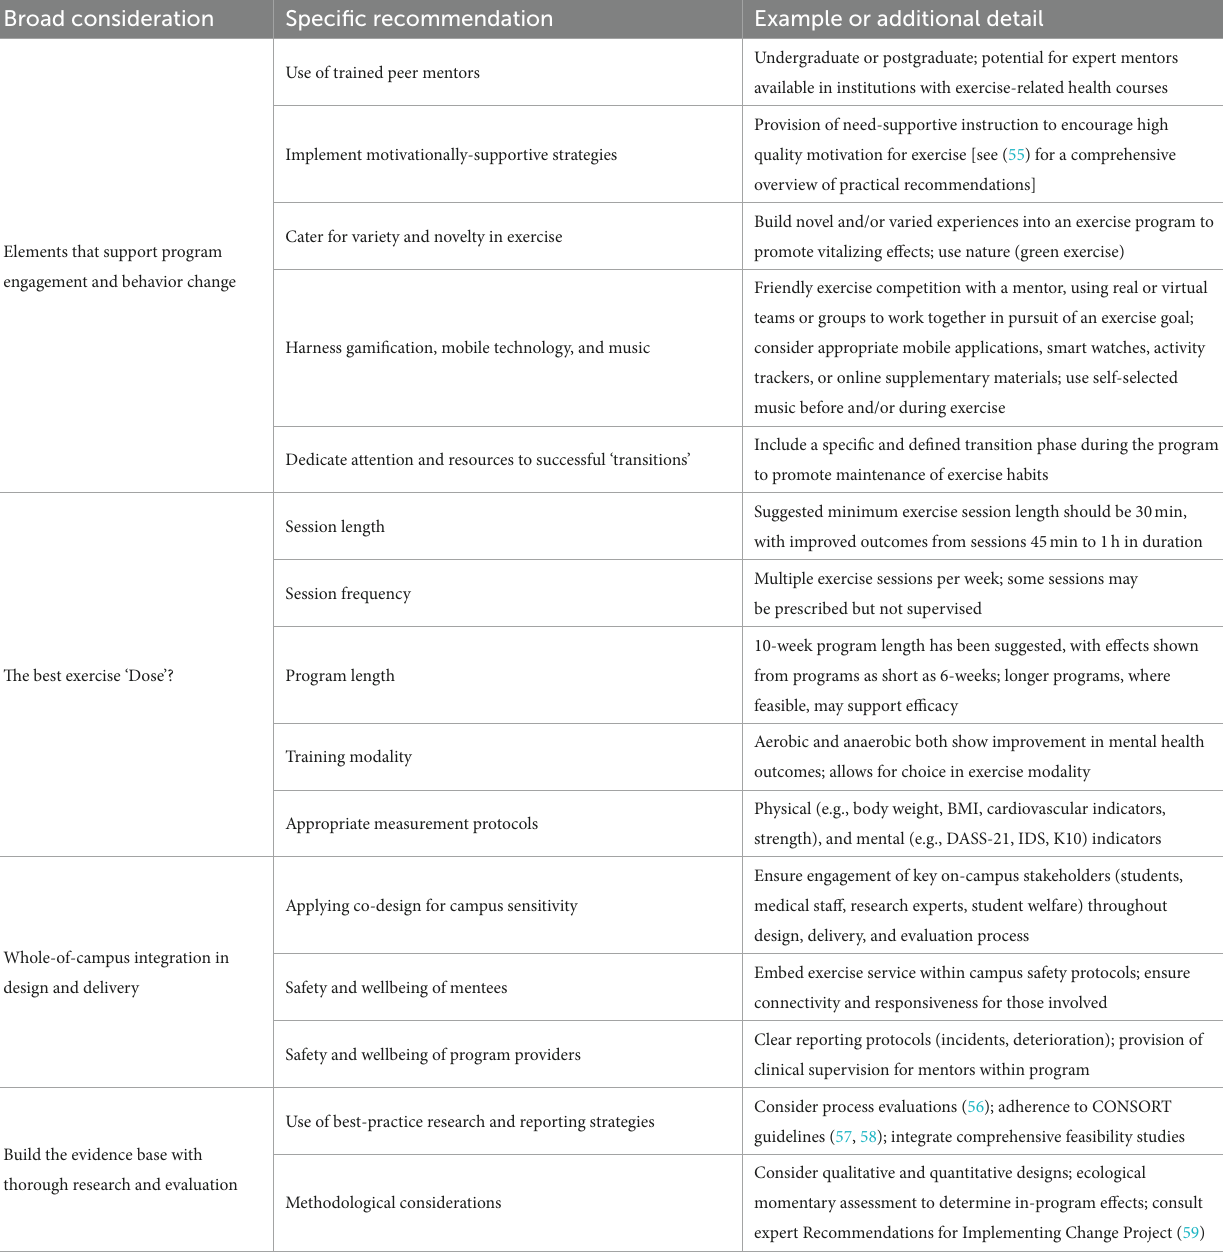
TABLE 1 A summary of considerations and specific